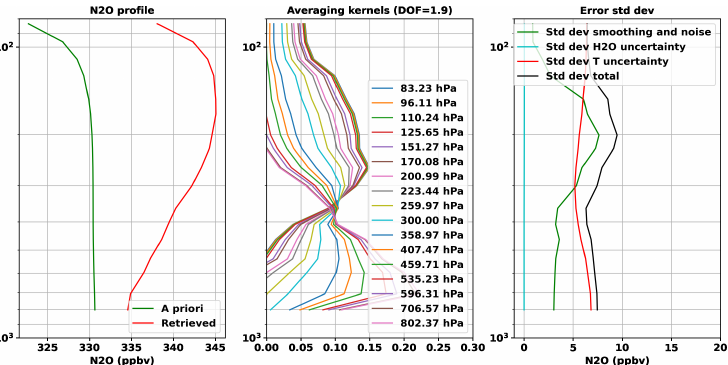
Figure 11. Example of retrieval results, averaging kernels and error analysis (standard deviation of the covariance matrices) for a tropical latitude (10.6° S 0.1° E), 15 December 2018.